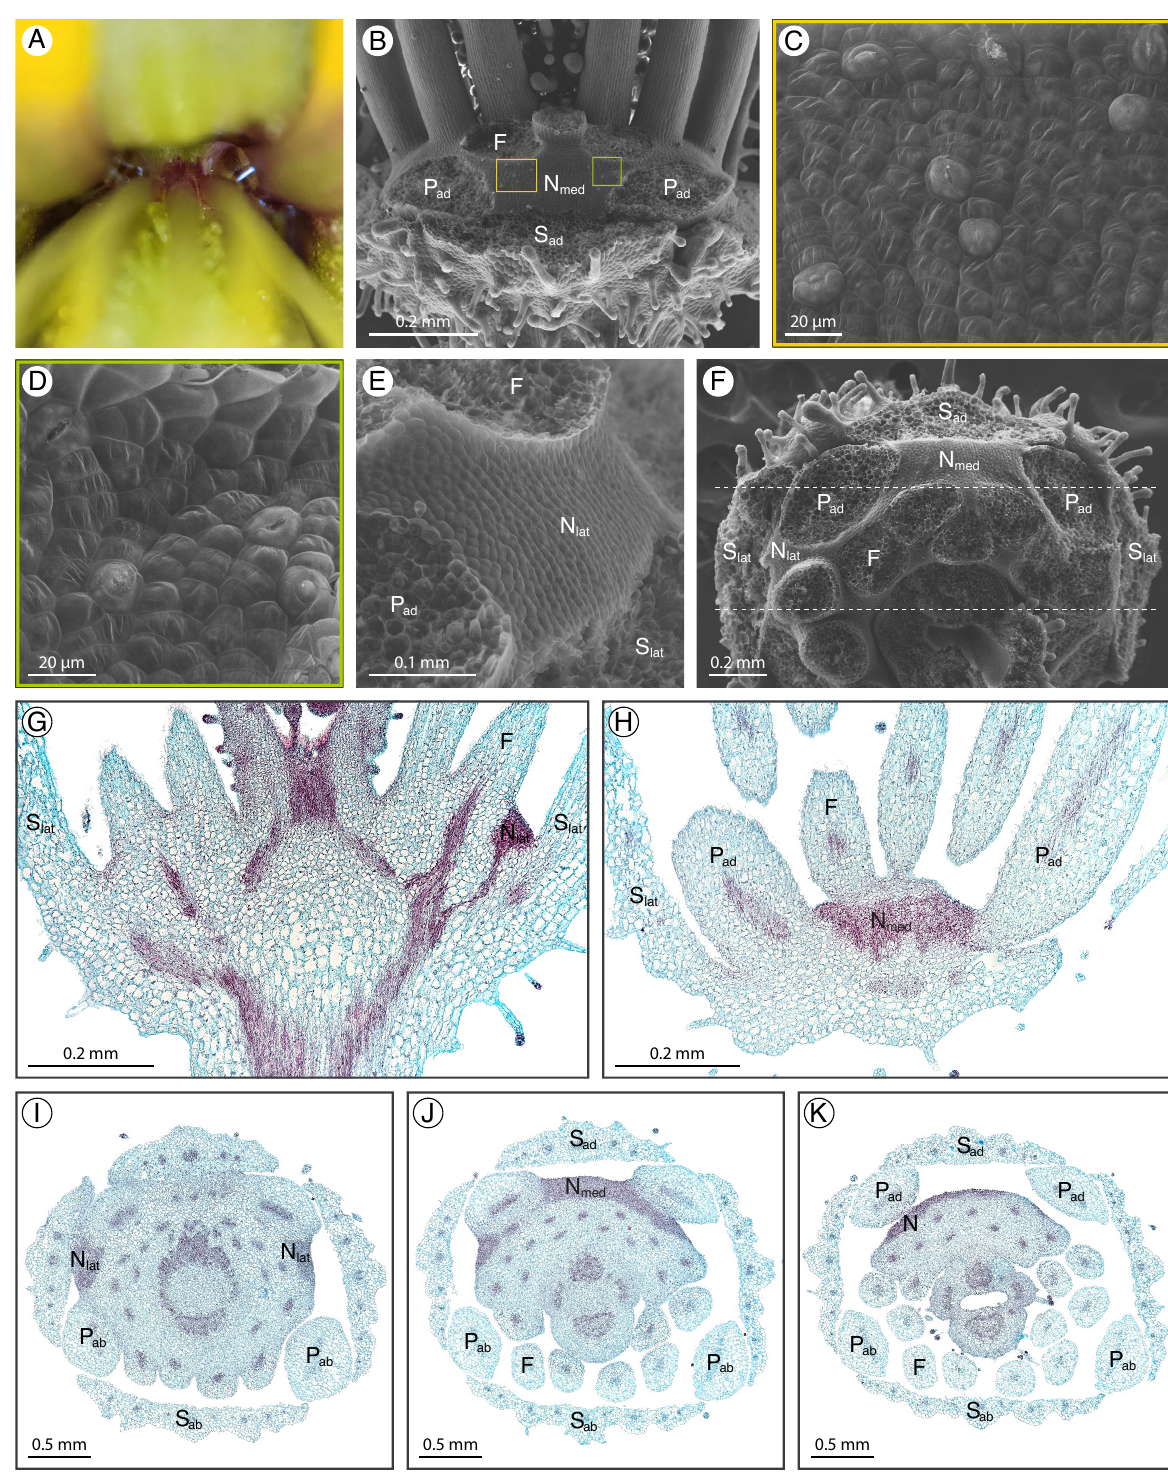
Figure 2. Arivela viscosa nectary ( A ) photograph, ( B – F ) scanning electron micrographs, and ( G – K ) fast green and safranin O-stained sections. ( A ) Apical view of the nectary. ( B ) Adaxial view of the nectary. ( C – E ) Adaxial view close-ups: ( C , D ) medial nectary lobe, corresponding to the left and right boxes in ( B ), respectively, and ( E ) lateral nectary lobe. ( F ) Apical view of the nectary. ( G , H ) Lon- gitudinal sections (frontal plane), corresponding to the bottom and top dashed lines in ( F ), respectively. ( I – K ) Transverse sections of the nectary from proximal to distal positioning. All images are of anthetic stage specimens. F: filament; N lat : lateral nectary lobe; N med : medial nectary lobe; P ab : abaxial petal; P ad : adaxial petal; S ab : abaxial sepal; S ad : adaxial sepal; S lat : lateral